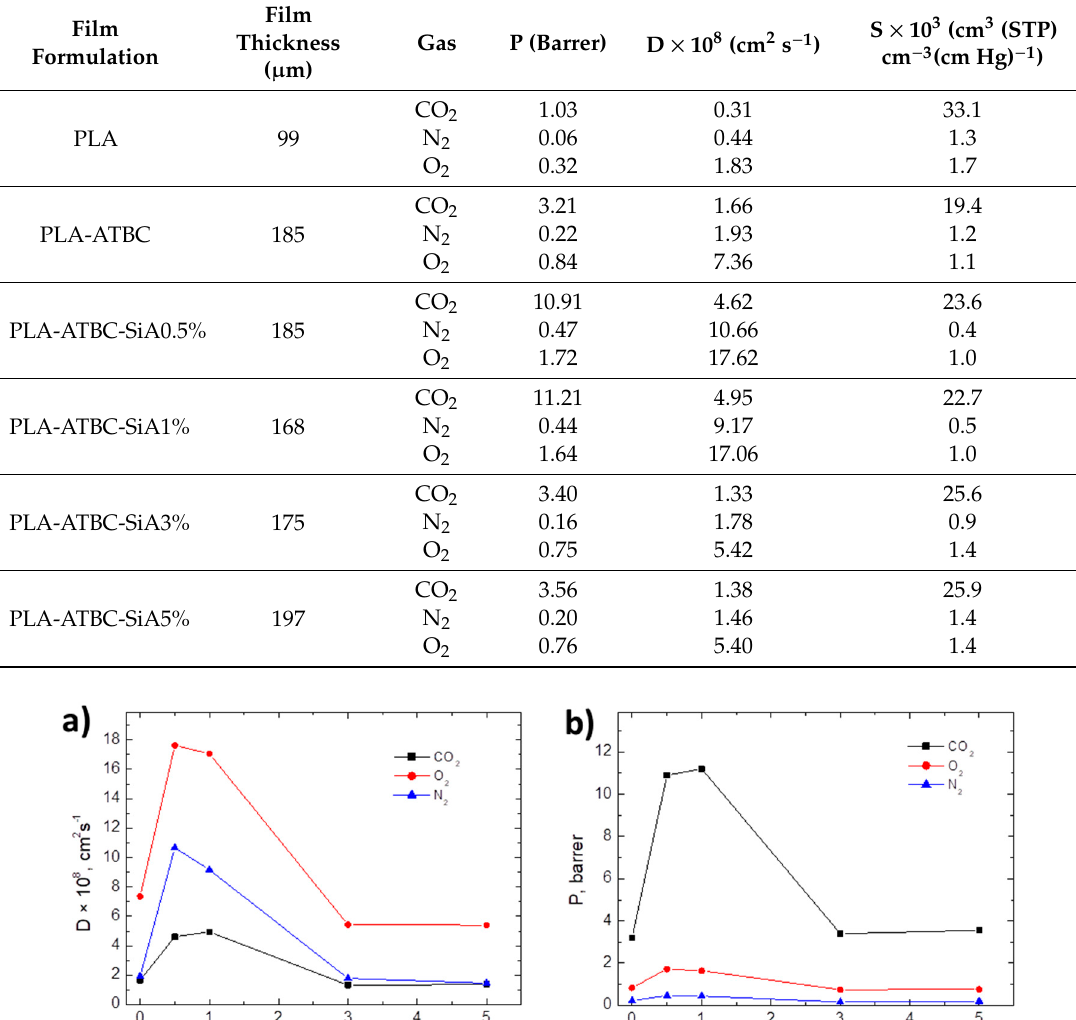
Table 4. Comparative values at 30 ◦ C of permeability (P), di ff usion (D) and apparent solubility (S) coe ffi cients of carbon dioxide, nitrogen and oxygen in PLA, PLA-ATBC and plasticized biocomposite films.